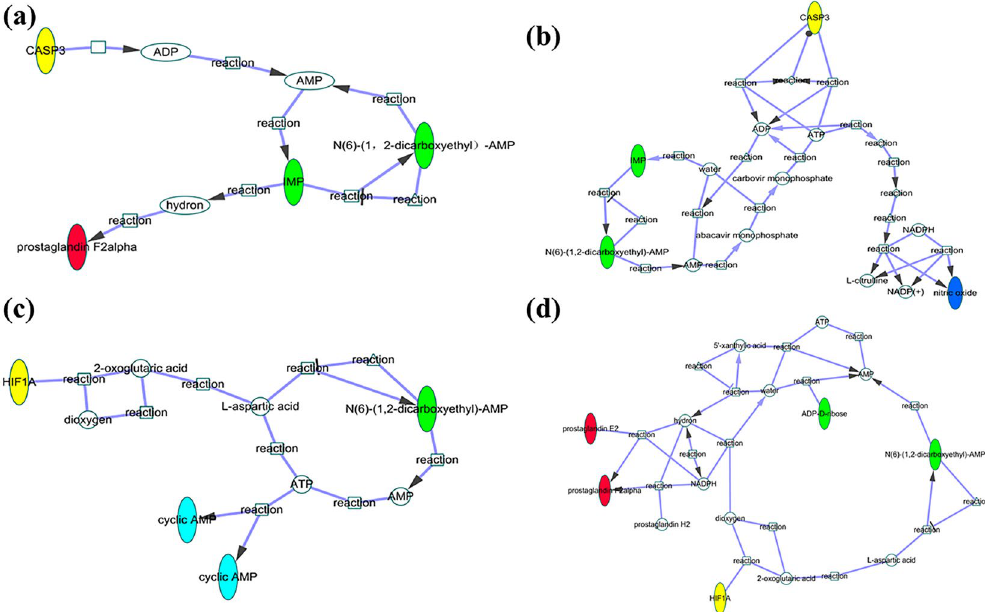
Figure 7. The metabolic pathway of baicalin-related targets relate to verified biomarkers and fever-related molecules. ( a ) The metabolic pathway of baicalin-related target CASP3 relate to fever-related molecule PGF2 α (Yellow indicates CASP3, green indicates IMP and N6-(1,2-dicarboxyethyl)-AMP and red indicates PGF2 α ); ( b ) Metabolic pathway of baicalin-related target CASP3 relate to fever-related molecule NO (Yellow indicates CASP3, green indicates IMP and N6-(1,2-dicarboxyethyl)-AMP and blue indicates fever-related molecule NO); ( c ) The metabolic pathway of baicalin-related target HIF-1 α relate to fever-related small molecule cAMP (Yellow indicates HIF-1 α , green indicates N6-(1,2-dicarboxyethyl)-AMP and azure indicates cAMP); ( d ) Metabolic pathway of baicalin-related target HIF-1 α to fever-related molecule PGE2, PGF2 α (Yellow indicates HIF-1 α , green indicates IMP and N6-(1,2-dicarboxyethyl)-AMP and red indicates PGE2, PGF2 α